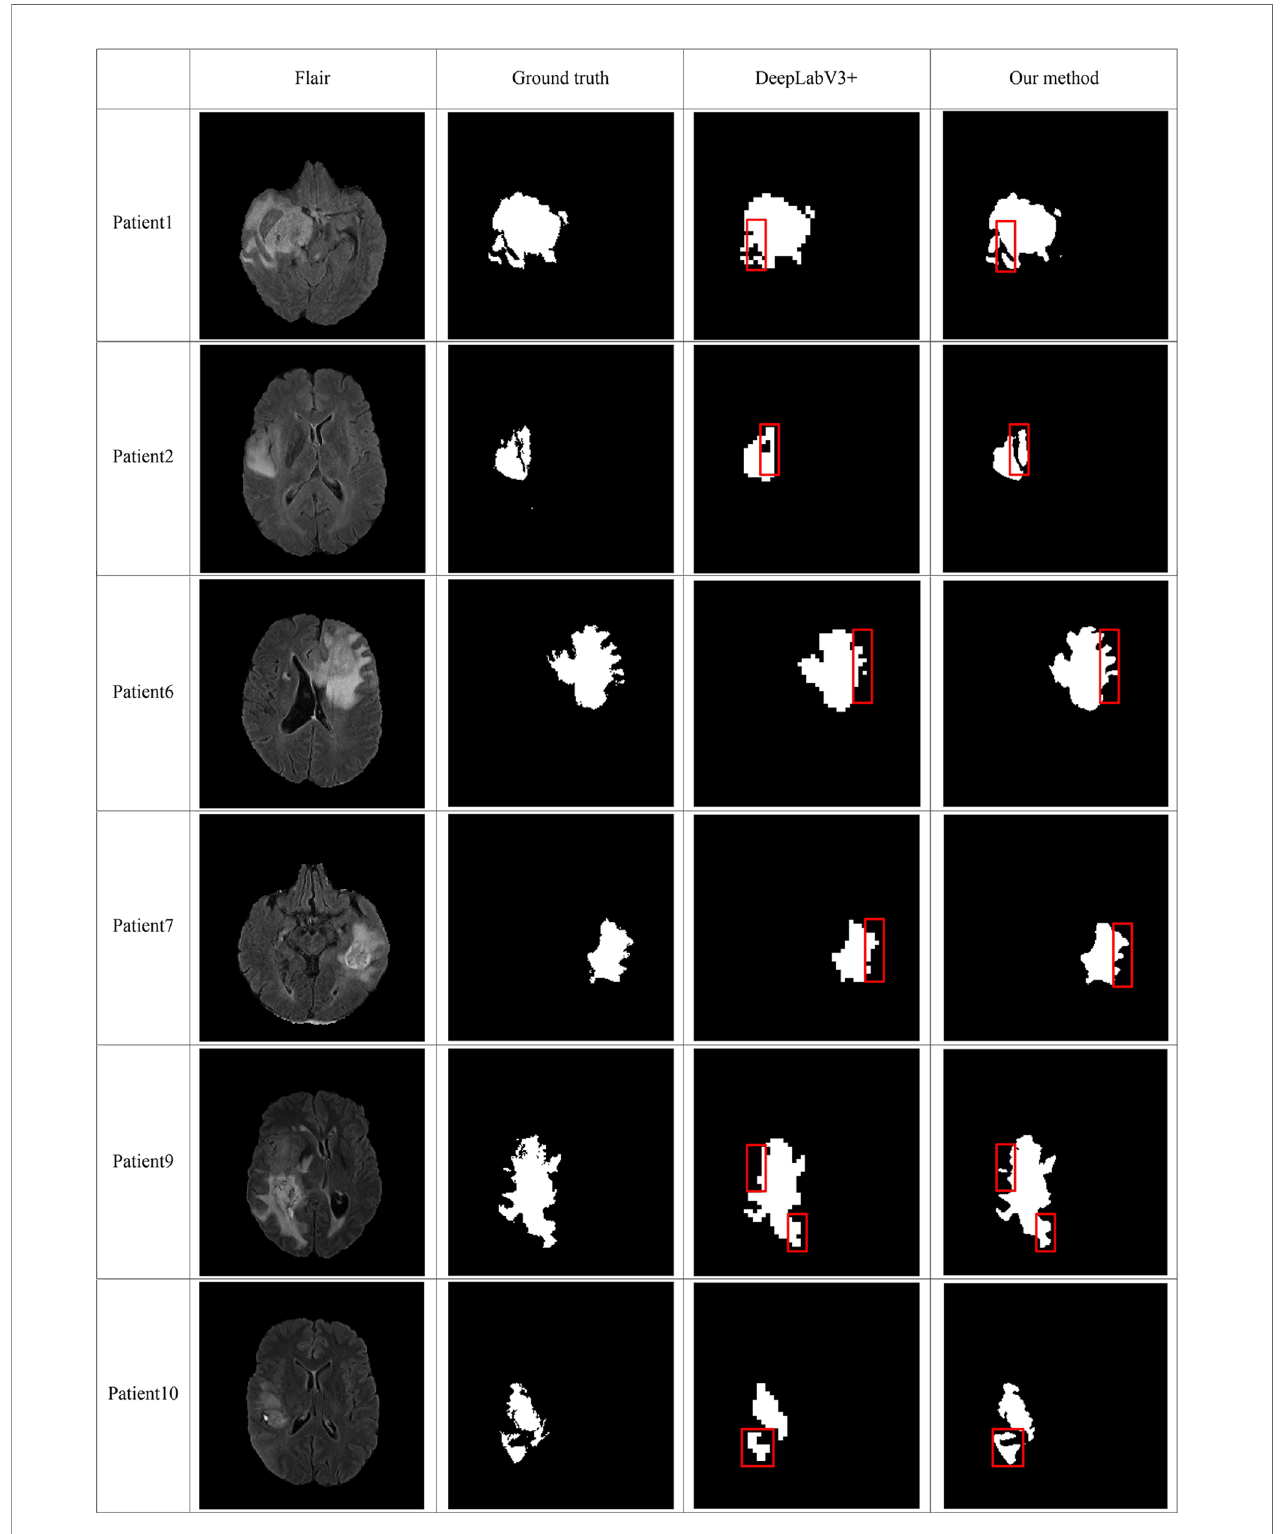
FIGURE 5 | Comparison of brain tumor segmentation results between our method and DeepLabV3+. The differences between the segmentation results of the two methods are marked by the red boxes.